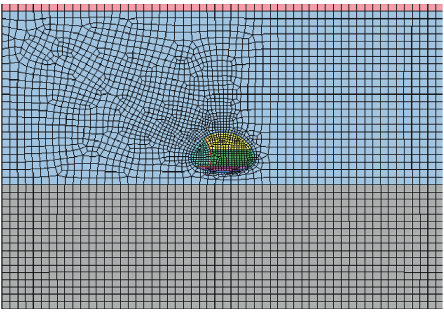
Figure 2: Numerical model